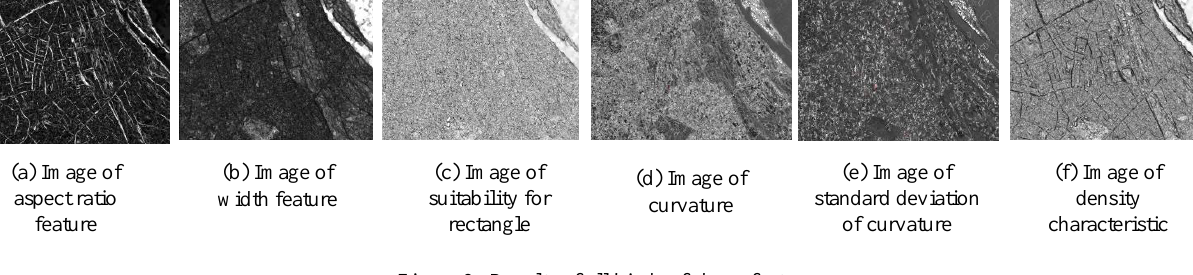
Figure 6. Results of all kinds of shape features Table 1. Object classification rules of Research